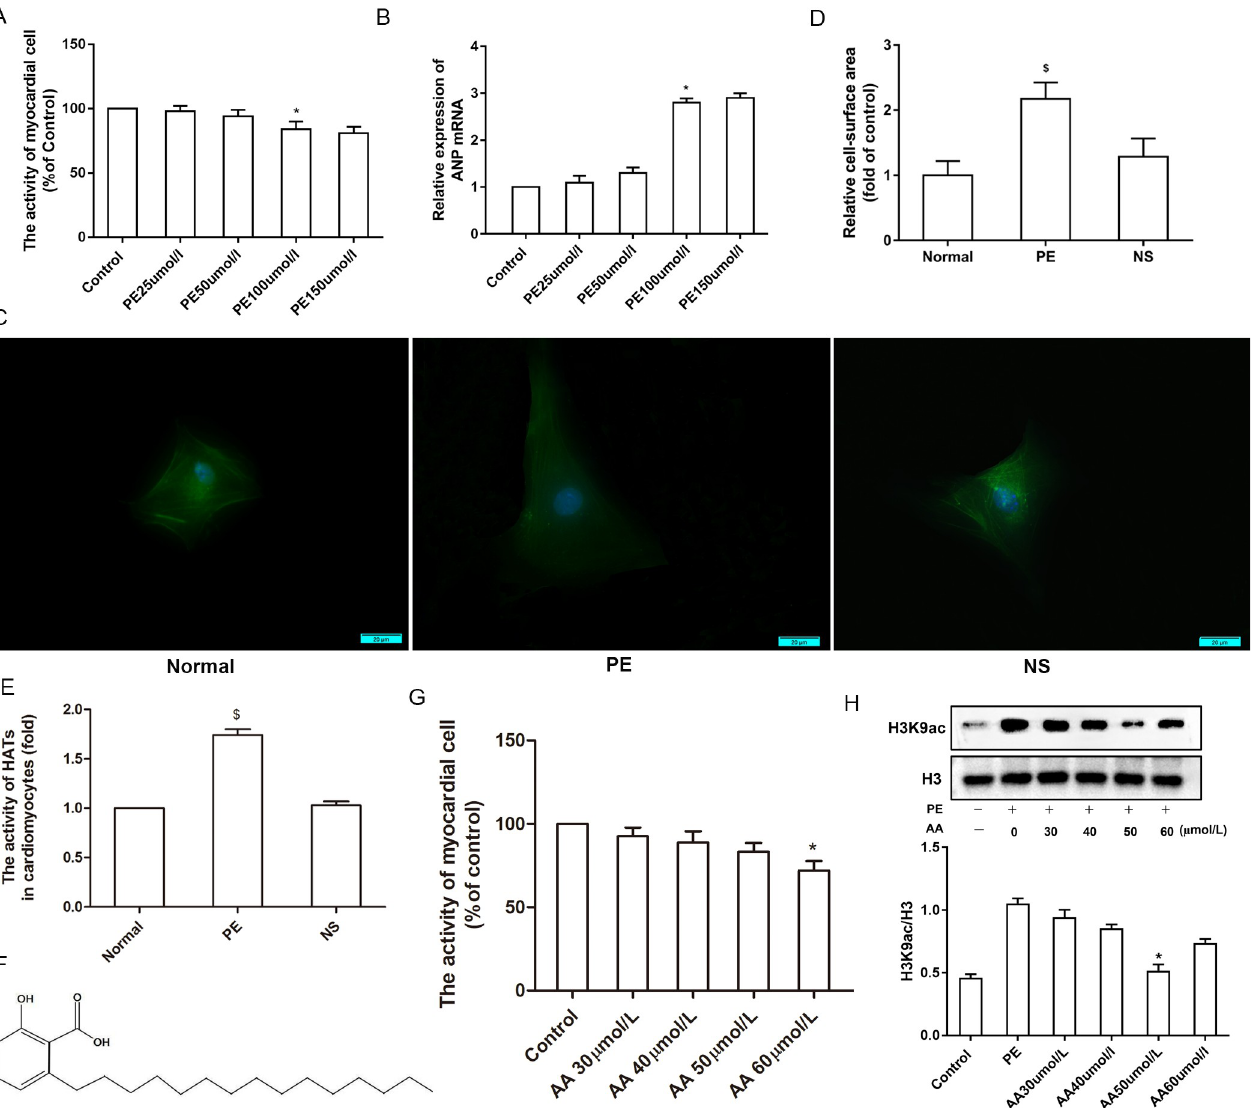
Fig 1. Activity of HATs in hypertrophic cardiomyocytes induced by phenylephrine (PE). Different concentrations of PE (0, 25, 50, 100, and 150 μ mol/L) were used to determine the optimal PE dose for the induction of cardiomyocyte hypertrophy in neonatal mice. (A) The effect of PE on cell viability was accessed using the Cell Counting Kit-8 assay in neonatal mouse cardiomyocytes. (B) Real-time PCR analysis of ANP mRNA expression after treatment with different concentrations of PE for 48 h. (C) The cardiomyocyte cytoplasm was stained with antibodies against α -actin, while the nuclei were stained with DAPI. The scale bars represent 20 μ m. (D) Quantification of cell surface areas in each treatment group. (E) The activity of HATs were assayed by colorimetry, and PE (100 μ mol/L) increased HATs activity. (F) The chemical structure of the HATs inhibitor anacardic acid (AA). ( G) Effect of different concentrations of AA (0, 30, 40, 50, and 60 μ mol/L) on cell viability of neonatal mouse cardiomyocytes by CCK-8 assays. (H) Different concentrations of AA (0, 30, 40, 50, and 60 μ mol/ L) were used to identify the optimal dose and 50 μ mol/L AA was selected based on the level of H3K9ac. NS: normal saline. � P < 0.05 vs . the control group, $ P < 0.05 vs . the normal group (n = 6). Fluorescence quantification was done using ImageJ 1.8.0_112 software (https://imagej.nih.gov/ij/, 1997–2018). Figure created in IBM SPSS version 25 (https://www.ibm.com/analytics/spss-statistics-software). The images in this figure were analyzed using Quantity One software Version 4.4